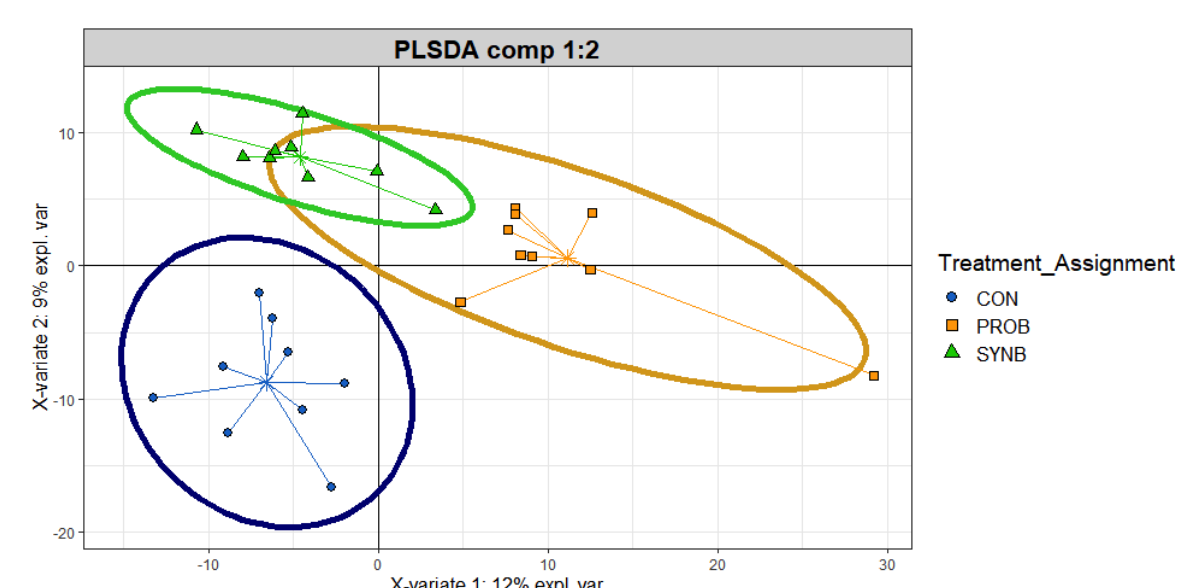
Figure 2. Partial least squares discriminant analysis scores plot of the ruminal transcriptionally active microbial community of beef steers fed diet, supplemented with direct-fed microbials containing multiple microbial species and their fermentation products. CON = control; PROB = a blend of S. cerevisiae , Enterococcus lactis, Bacillus subtilis, Enterococcus faecium, and L. case i, and their fermentation products fed at 19 g/steer/day (PMI, Arden Hills, MN); SYNB = a blend of live S. cerevisiae and the fermentation products of S. cerevisiae, Enterococcus lactis , Bacillus licheniformis , and Bacillus subtilis fed at 28 g/steer/day PMI, Arden Hills, MN) .